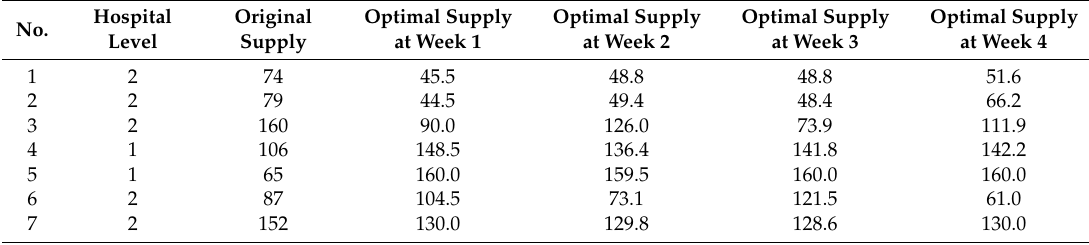
Table 2. Supply before and after the optimal